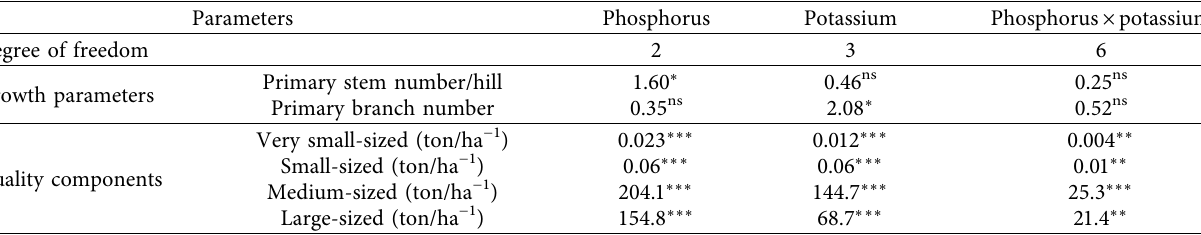
Table 2: Mean squares values of potato growth and quality components as influenced by phosphorus and potassium and their interaction.